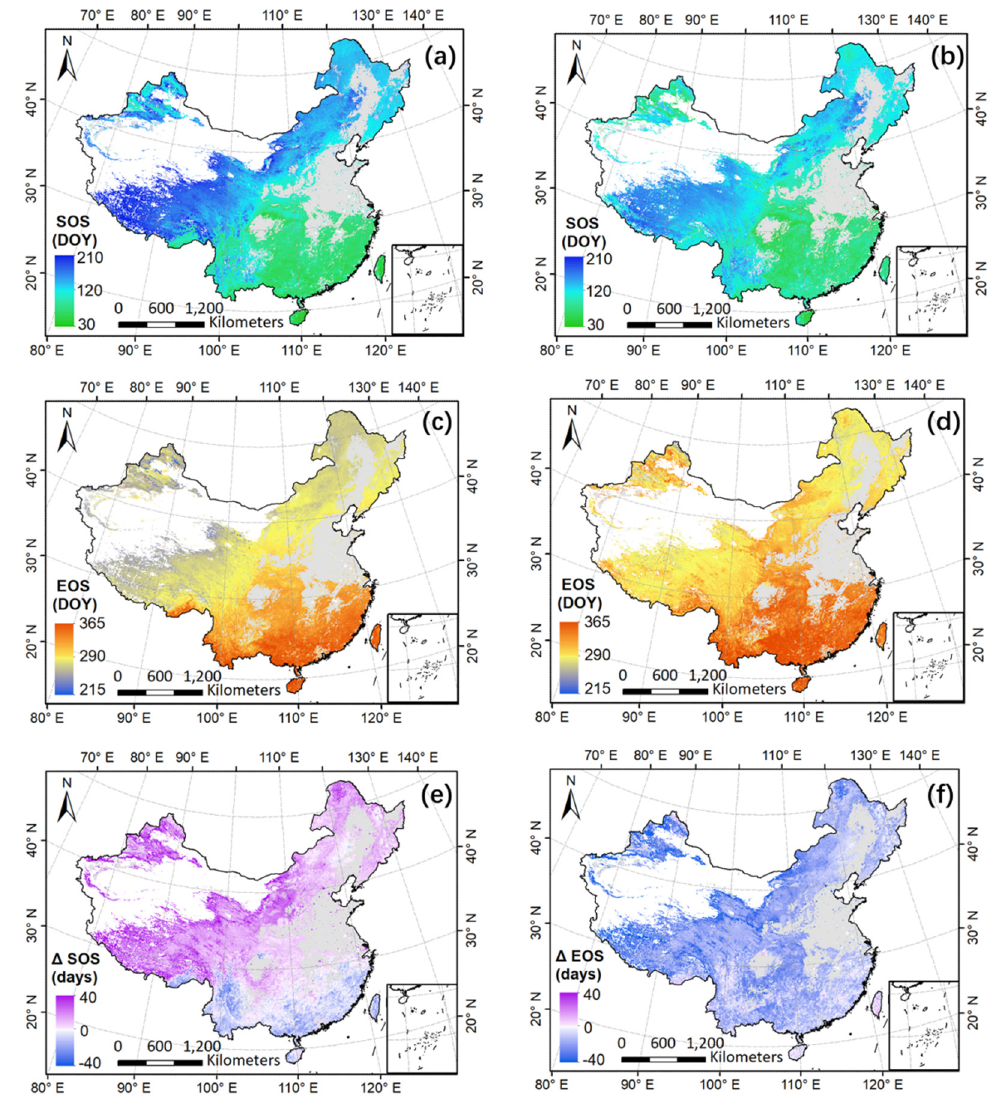
Figure 2. The spatial pattern of multi-year average phenology of natural vegetation from SIF ( a , c ) and EVI ( b , d ) and their differences, i.e., SOS/EOS derived from SIF subtracted by that derived from EVI ( e , f ).